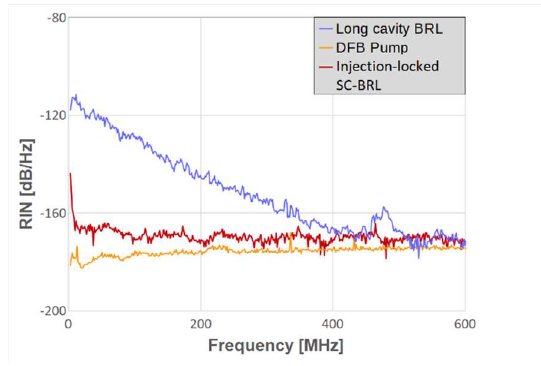
Fig. 6. Comparison of the RIN profiles of the sources